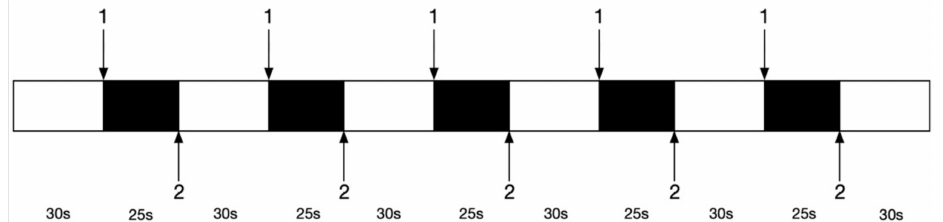
Figure 3. The event design diagram. Mark 1 means the signal of the perturbation and Mark 2 means the signal of